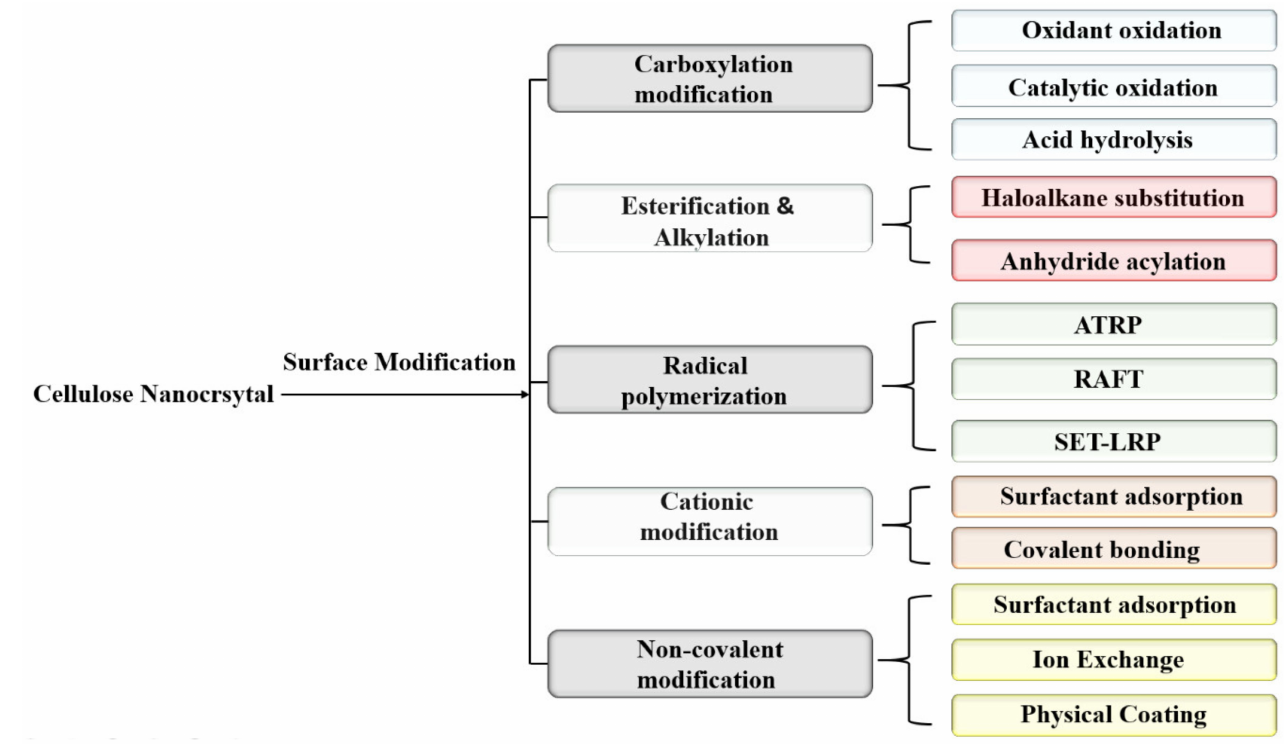
Figure 3. Surface functionalization of CNCs by different